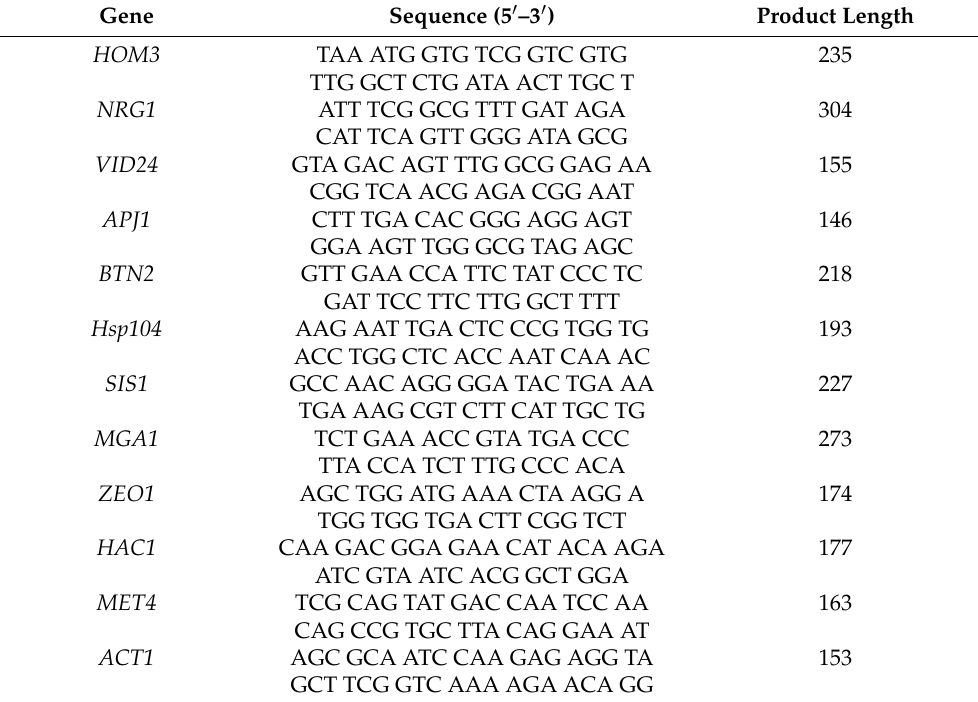
Table 1. Primers used for RT-qPCR and PCR analysis.